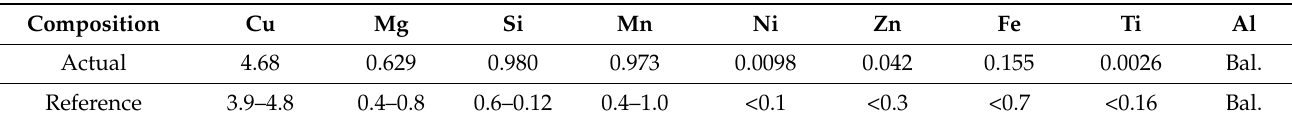
Table 1. Actual and reference chemical composition of the 2A14 aluminum alloy